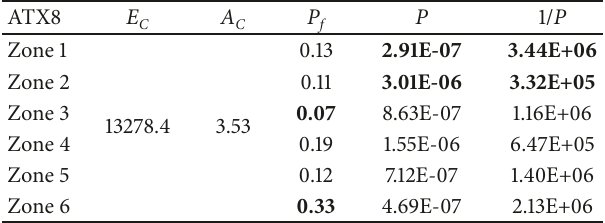
Table 9: Results for Zenith